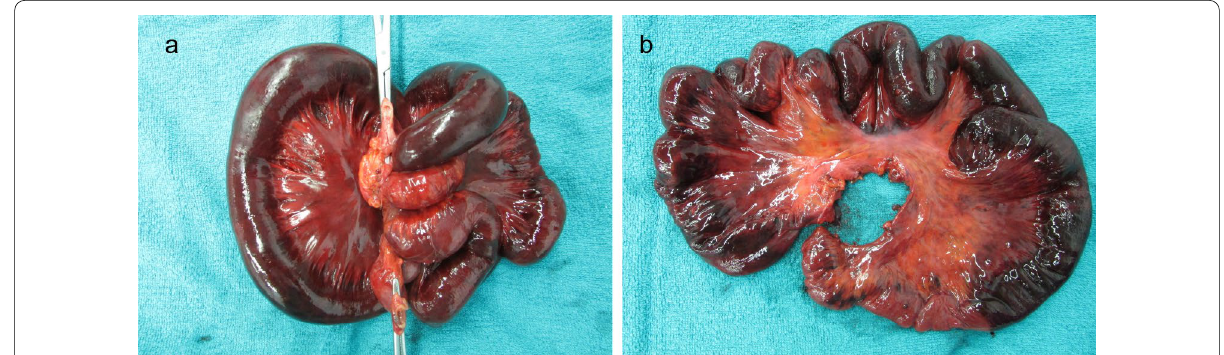
Fig. 3 Findings of resected specimen. a Before releasing the knot. b After releasing the knot